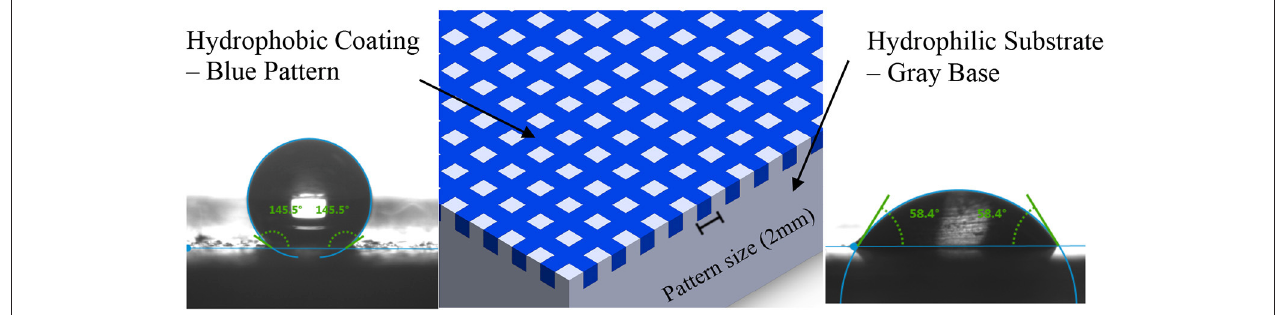
FIGURE 1 | Schematic drawing of biphilic surface showing the hydrophobic pattern on a hydrophilic base. The contact angle of water on the hydrophobic and hydrophilic sites are 145 ◦ and 58 ◦ ,